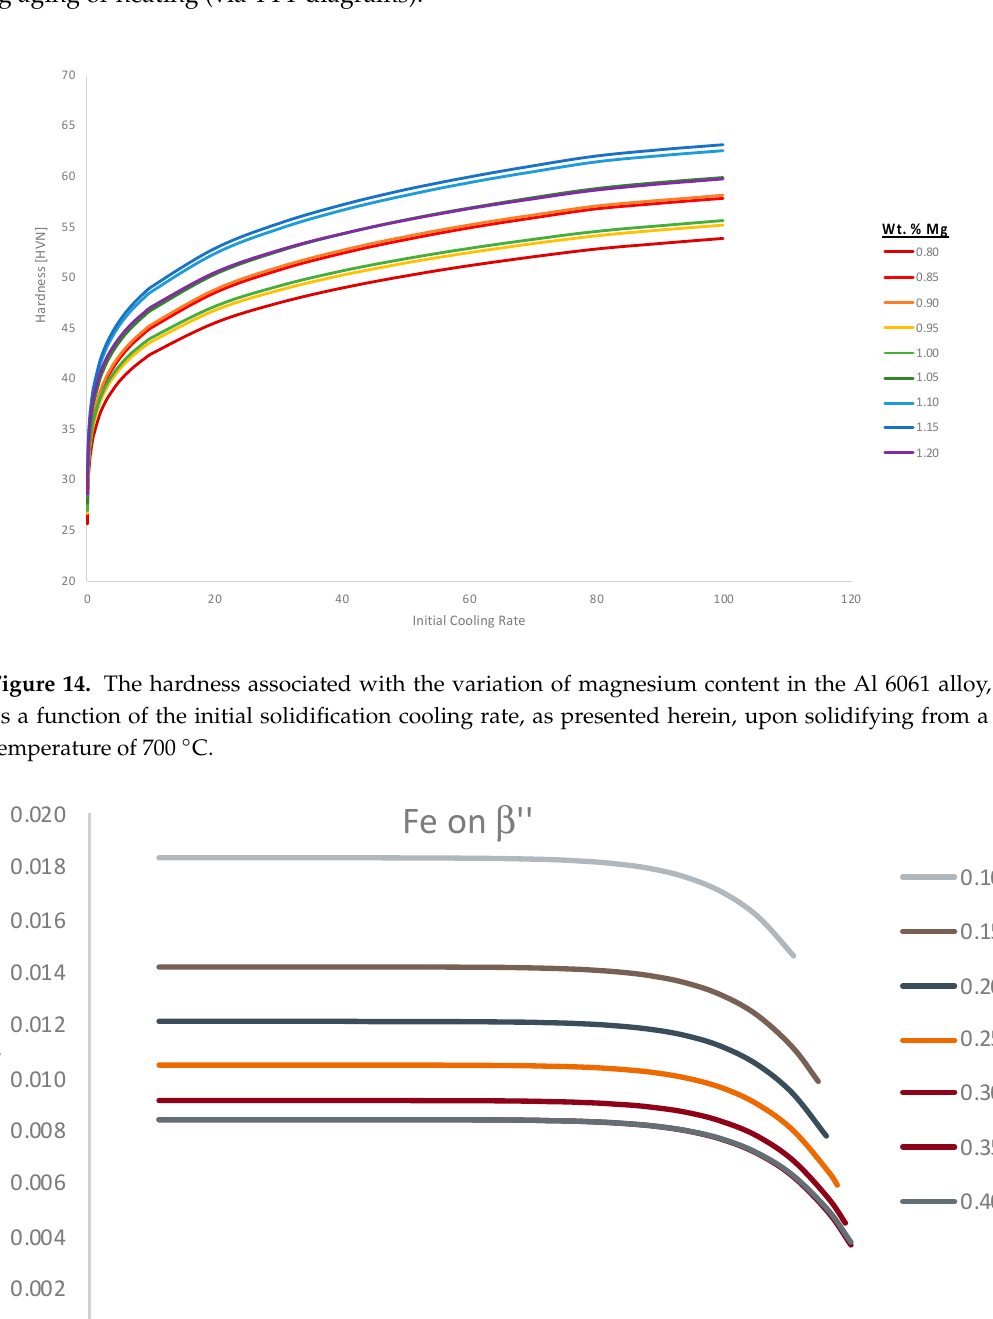
Figure 13. The influence of chromium upon β″ and β′ are presented in ( a , b ), respectively. As for chromium and iron in relation to Mg 2 Si, chromium was found to have a greater 𝜓 at 2.8, as noted in ( c ), versus that of 2.0 for the effect of iron on Mg 2 Si, as shown in ( d ), under the same conditions.